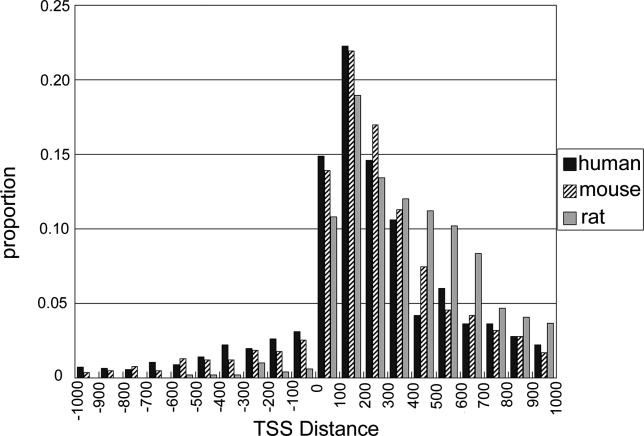
Distribution of TSS Distance of Head-to-Head Genes